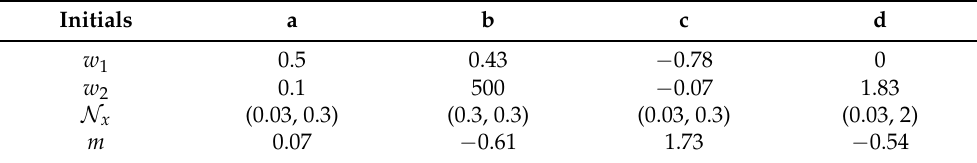
Table 2. Initial parameters of the toy example. Note that m stands for the target slope, and N x denotes the mean and variance of the samples. All samples were normally distributed.